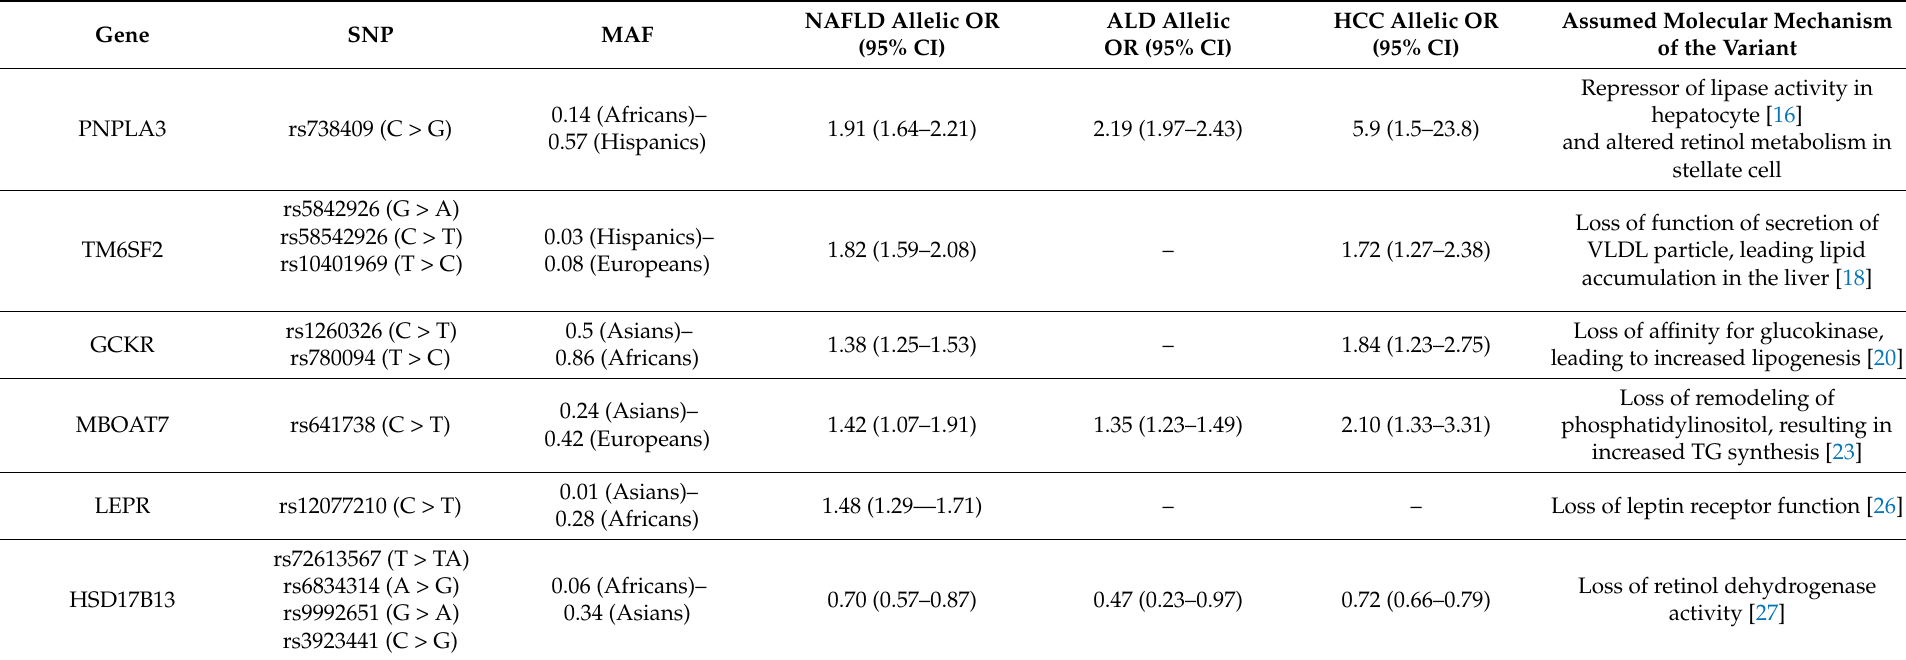
Table 1. Genetic Variants Associated with